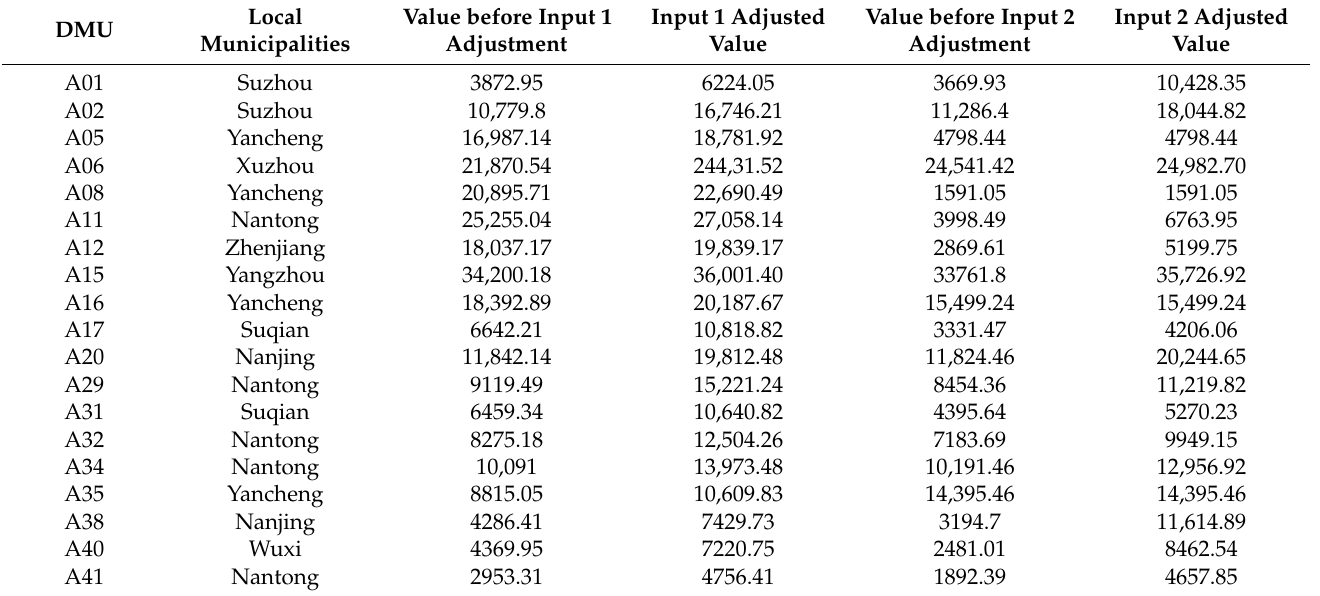
Table 7. The 19 projects to meet the electricity demand and the phase input adjustment (sorted by